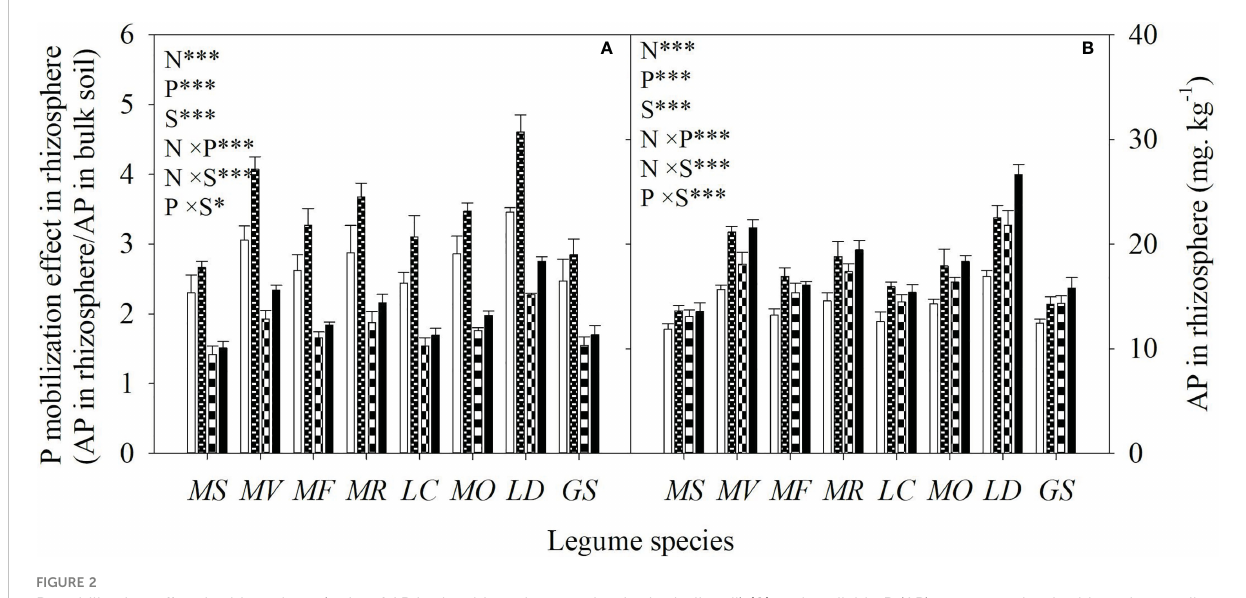
FIGURE 2 P mobilization effect in rhizosphere (ratio of AP in the rhizosphere to that in the bulk soil) (A) and available P (AP) concentration in rhizosphere soil (B) under control (no fertilizer addition), N (N addition), P (P addition) and NP (addition of both N and P) for eight legume species. MS, Medicago sativa ; MV, Medicago varia ; MF, Medicago falcata ; MR, Medicago ruthenica ; LC, Lotus corniculatus ; MO, Melilotus of fi cinalis ; LD, Lespedeza daurica ; GS, Glycine soja. Letters (N, P, S, N×P, N×S, P×S, N×P×S) indicate signi fi cance overall from N addition, P addition, legume species (S) and their interaction effects according to general linear model P-values, the signi fi cance level are reported as ***(P<0.001), **(P<0.01), *(P<0.05). Inside the embedded fi gures, the bars represent the means of each independent factor and interacted treatment with signi fi cant